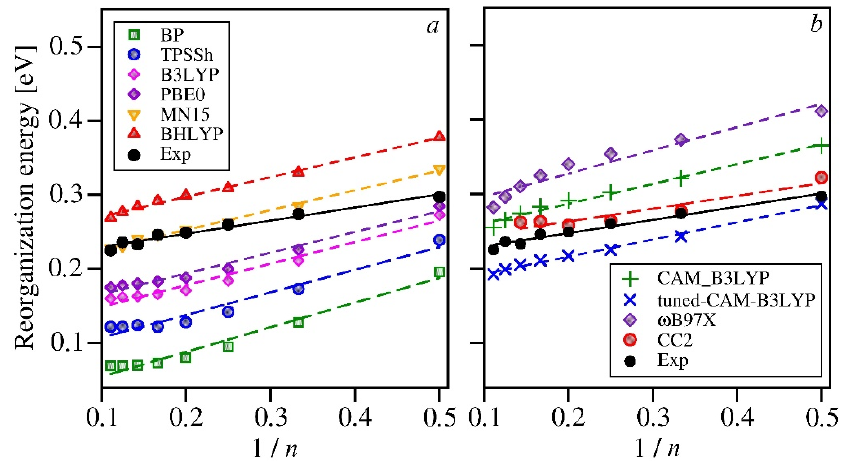
Figure 4. Experimental and caculated values of the averaged reorganization energies for the studied oligofurans with respect to the reciprocal number of rings (1/ n ). Dashed lines represent linear fits to the computed energies. Fitted parameters are collected in Table 4. (For the sake of clarity the results obtained with the GGA and hybrid functionals are shown in panel ( a ), while those yielded by the range corrected functionals and CC2 are shown in panel ( b )).